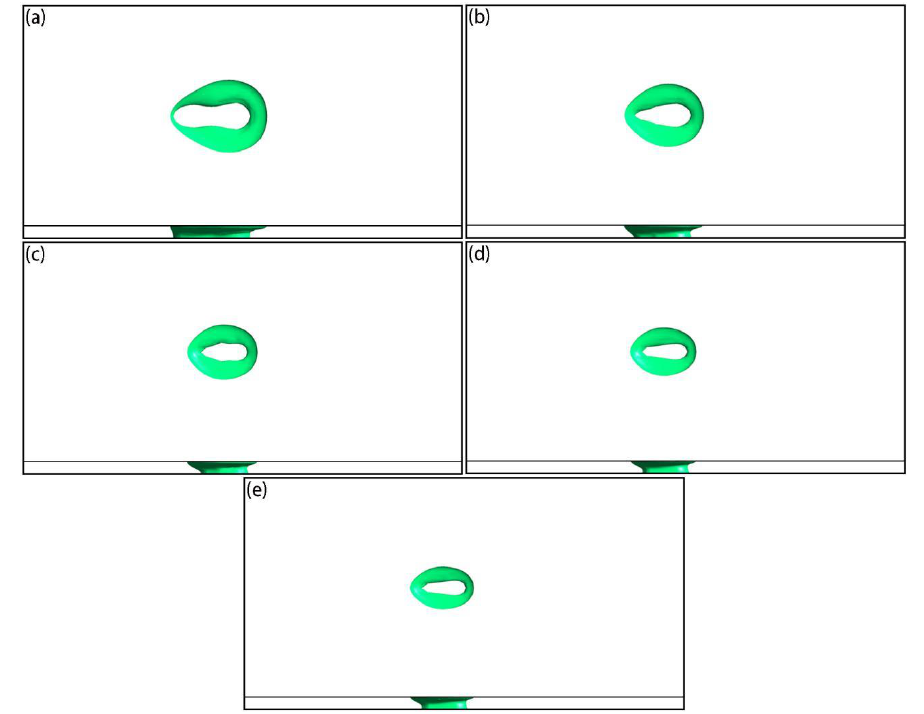
Figure 16. Simulation results of top- and side-view molten pool shapes under different scanning speeds when the laser acted on the center of the powder layer: ( a ) 0.4 m/s; ( b ) 0.5 m/s; ( c ) 0.6 m/s; ( d ) 0.7 m/s; ( e ) 0.8 m/s.